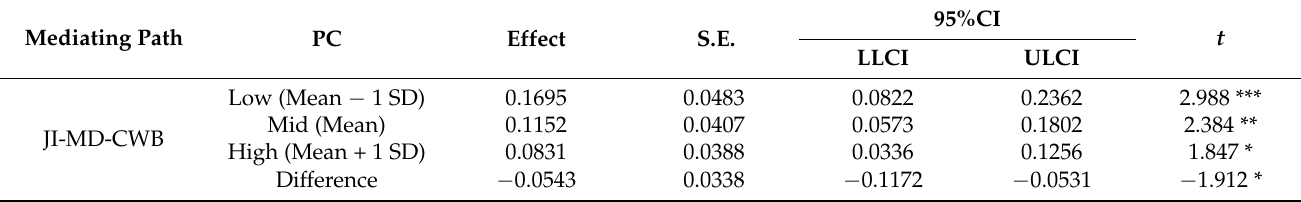
Table 4. Bootstrap results for the moderated mediation effect analysis of